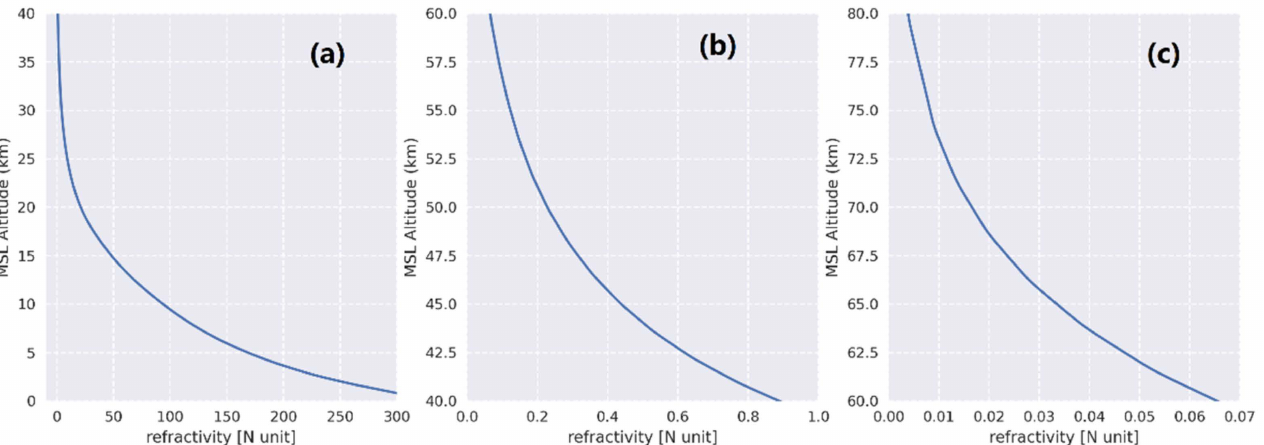
Figure A6 is the same as Figure 7 but based on the log-linear interpolation. Below the height of 35 km, the RD and difference of EC4Dvar become ± 1%, ± 1 × 10 − 5 from 0.5% and ± 0.5 × 10 − 5 in Figure 7. Between 35 to 50 km, those values are the same, less than 5%. In terms of FNL and ERA5, more RD values reach ± 4% below 35 km, and more of those are over ± 5% above 35 km. There is more undulation for results based on linear